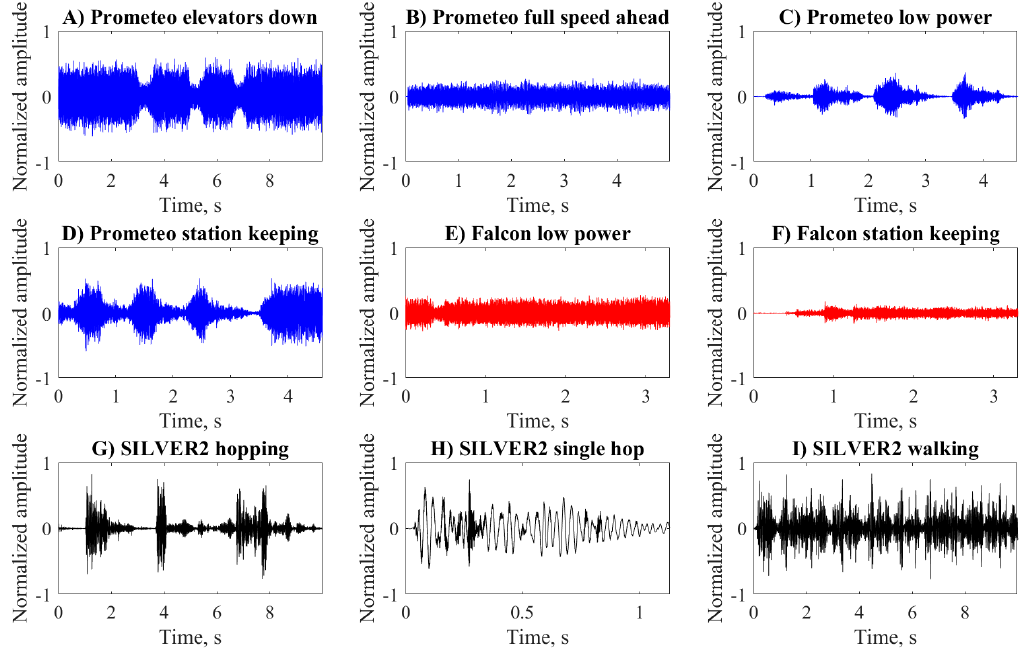
Figure 2. Raw mp3 signals of Prometeo (blue), Falcon (red), and SILVER2 (black) performing various maneuvers.